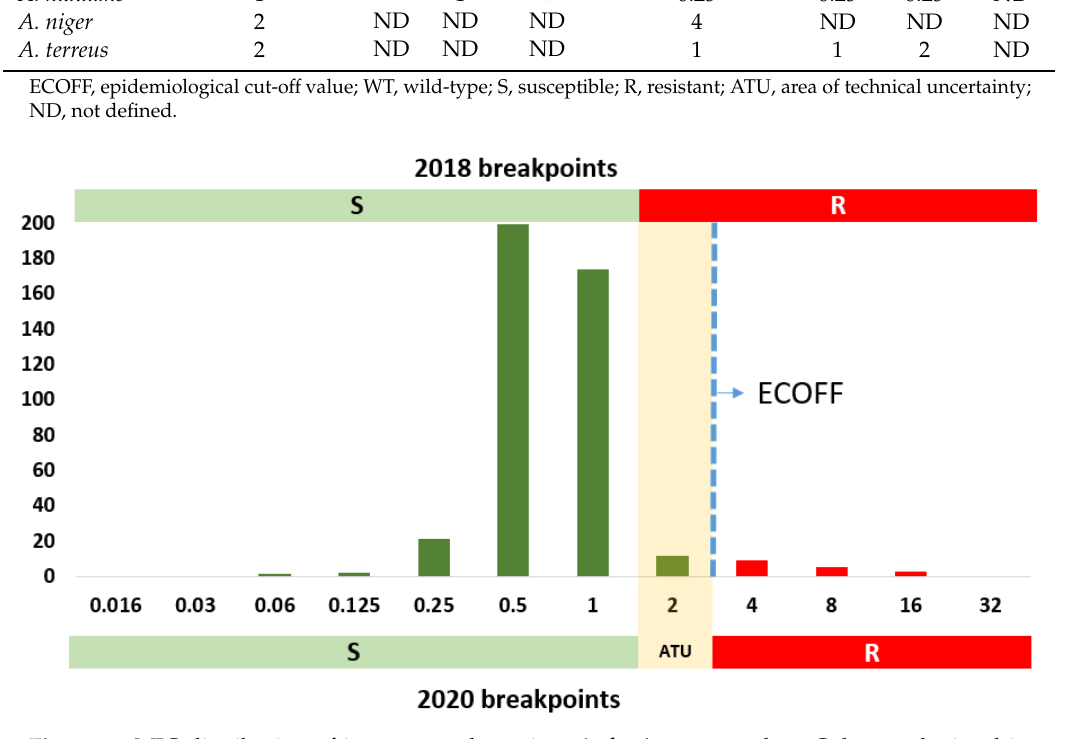
Figure 3. MIC distribution of isavuconazole against A. fumigatus complex. Columns depicted in green represent phenotypically isavuconazole wild-type isolates; columns depicted in red represent phenotypically isavuconazole non-wild-type isolates. Horizontal bars indicate clinical breakpoints for the S (green) and R (red) categories; new (2020) and former (2018) breakpoints are shown. The new area of technical uncertainty (ATU) is represented as a light orange shaded column (2 mg / L). Data extracted from the isavuconazole vs. Aspergillus rational document v2.0 (https: // www.eucast.org / asto ff ungi